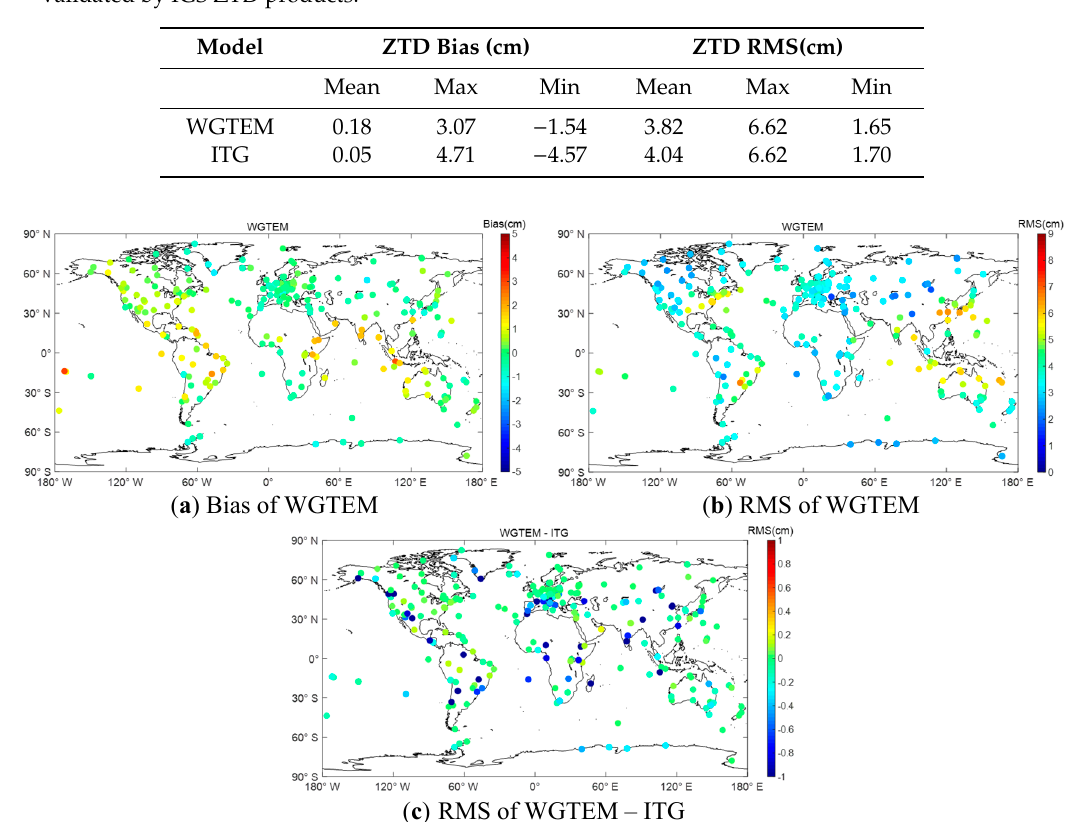
Figure 8. ZTD bias and RMS from WGTEM at each station and comparison with RMS from ITG model, validated by NOAA data.